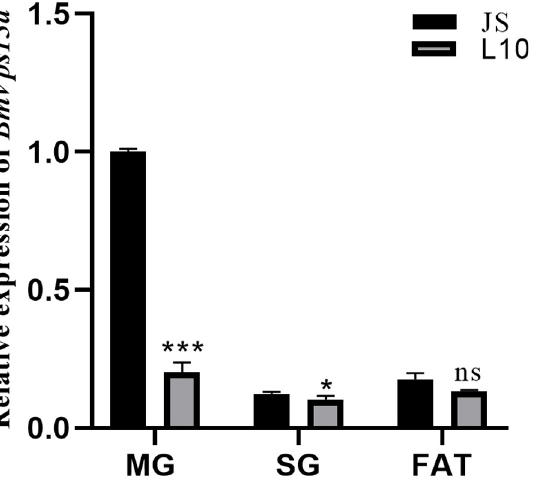
Fig 2. BmVps13d expression in midgut, silk gland, and fat body of JS and L10 by RT-qPCR. The histograms show the relative transcript levels of BmVps13d . MG, midgut; SG, silk gland; FAT, fat body. All data are representative of three independent experiments and are expressed as the mean ± standard error of the mean (SEM). A two-tailed t -test is used to evaluate gene expression difference in midgut, silk gland, and fat body between JS and L10 at the third day of fifth instar larval stage. P -values are described as follows: � P � 0.05, �� P � 0.01, ��� P �